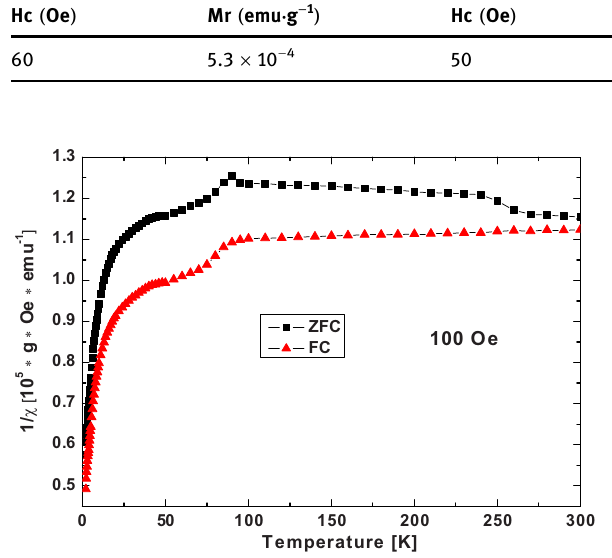
Table 1: Parameters of the magnetic hysteresis loop at room temperature TiO 2 /rGO - 8 - 400